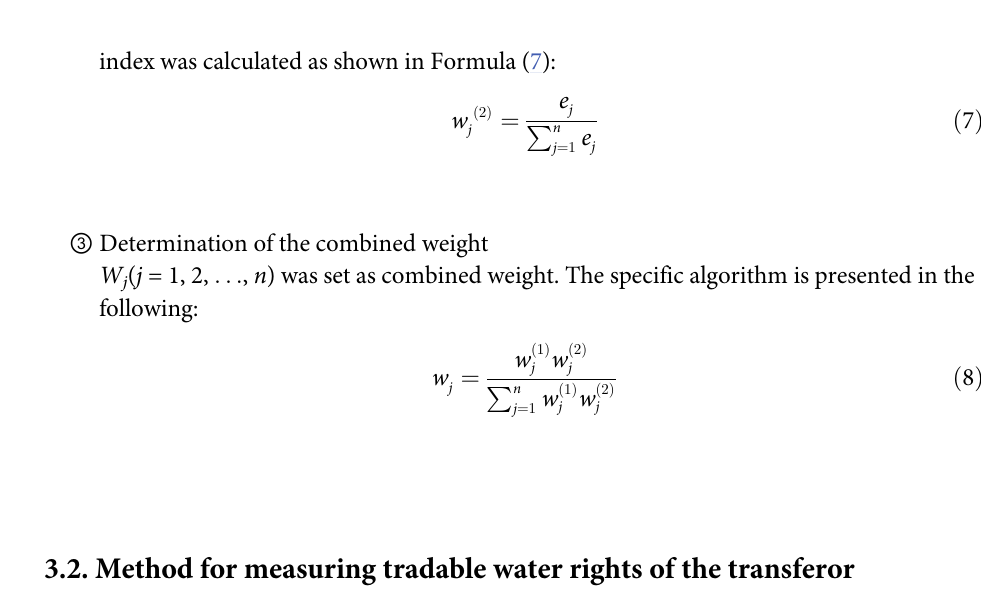
algorithm model. The simulated annealing algorithm is a stochastic optimization